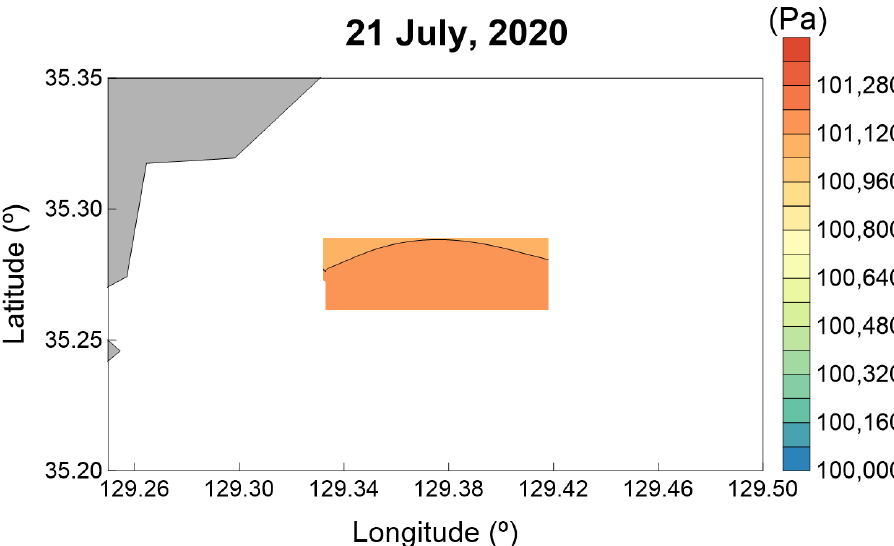
Figure 17. Distribution of atmospheric pressure in the Gijang coastal waters sea (21 July, 2020).